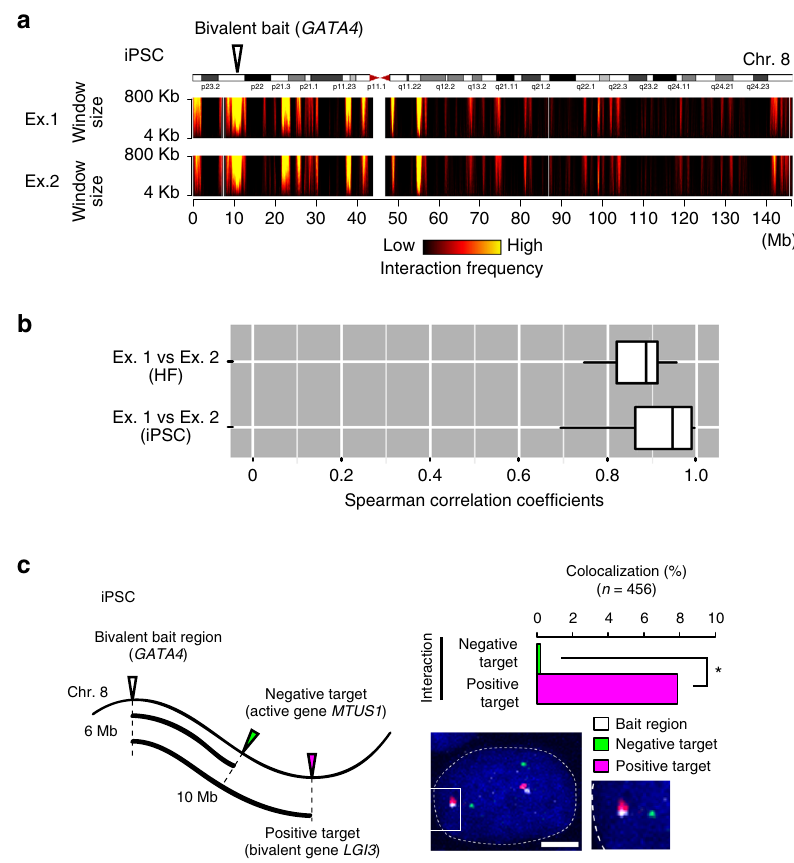
Fig. 2 Examination of chromatin interaction pro fi les at bivalent gene loci. a Cis -chromosomal interaction pro fi les at the GATA4 (bivalent in PSCs) gene locus in hiPSCs. Interaction frequencies of the GATA4 gene locus, as determined by ms4C-seq, are presented by the domainogram in biological duplicates (Ex. 1 and Ex. 2). The color scale represents the log 10 ( p -value) interaction frequencies from low signi fi cance ( p = 1) to high signi fi cance ( p = 10 – 10 ), with colors from black to yellow, respectively. b Analysis of the reproducibility of two independent ms4C-seq experiments in HFs (HDFs) and iPSCs. Boxplots indicate the distribution of the Spearman correlation coef fi cients of interaction signals among biological replicates (Ex. 1 vs. Ex. 2). c Analysis of chromatin interactions with 3D DNA FISH in iPSCs. The left panel illustrates the positions of positive (bivalent gene LGI3 in PSCs) and negative (active gene MTUS1 in PSCs) interaction target loci relative to the bait (bivalent gene GATA4 in PSCs) locus on the genome. The bar graph in the right panel shows the colocalization percentage between the GATA4 locus and the positive (magenta) or negative (green) interaction loci ( n = 456, Fisher ’ s exact test, * p < 1 × 10 – 8 ). The right lower panel shows a nuclear image of 3D DNA FISH with Z-projection. Nuclei are stained with Hoechst (blue). The bait locus ( GATA4 ), interaction-positive locus ( LGI3 ), and interaction-negative locus ( MTUS1 ) are indicated in white, magenta, and green, respectively. Scale bar, 5 μ m. See also Supplementary Fig. 2 and Supplementary Tables 2 and